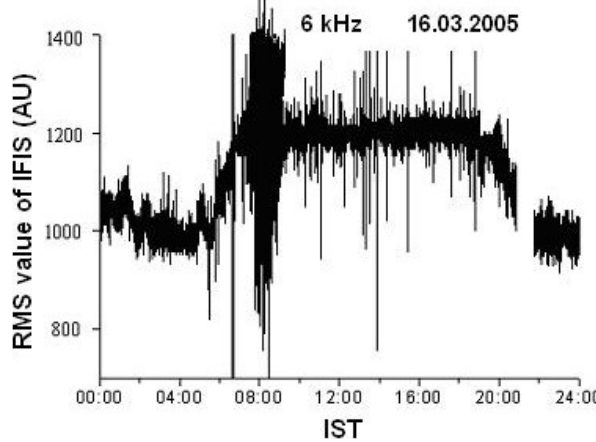
Fig. 4. A record of IFIS on a rainy day with overhead shower 07:10 to